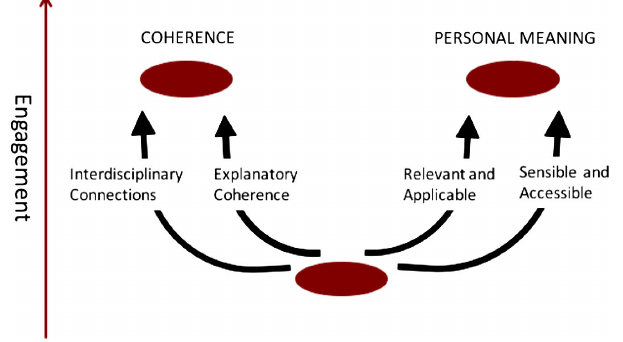
reasons. Students described high levels of interest in contexts that fostered a sense of coherence (left-hand side) or a sense of personal meaning (right-hand side). The most prominent “ en- gagement pathways ” (black arrows) are shown, and labeled by the factor that is key in facilitating increased engagement relative to the student ’ s initial, pre-IPLS state. The pre-IPLS state is represented by the middle red oval from which all the pathways emerge, and the meaning of each factor is unpacked